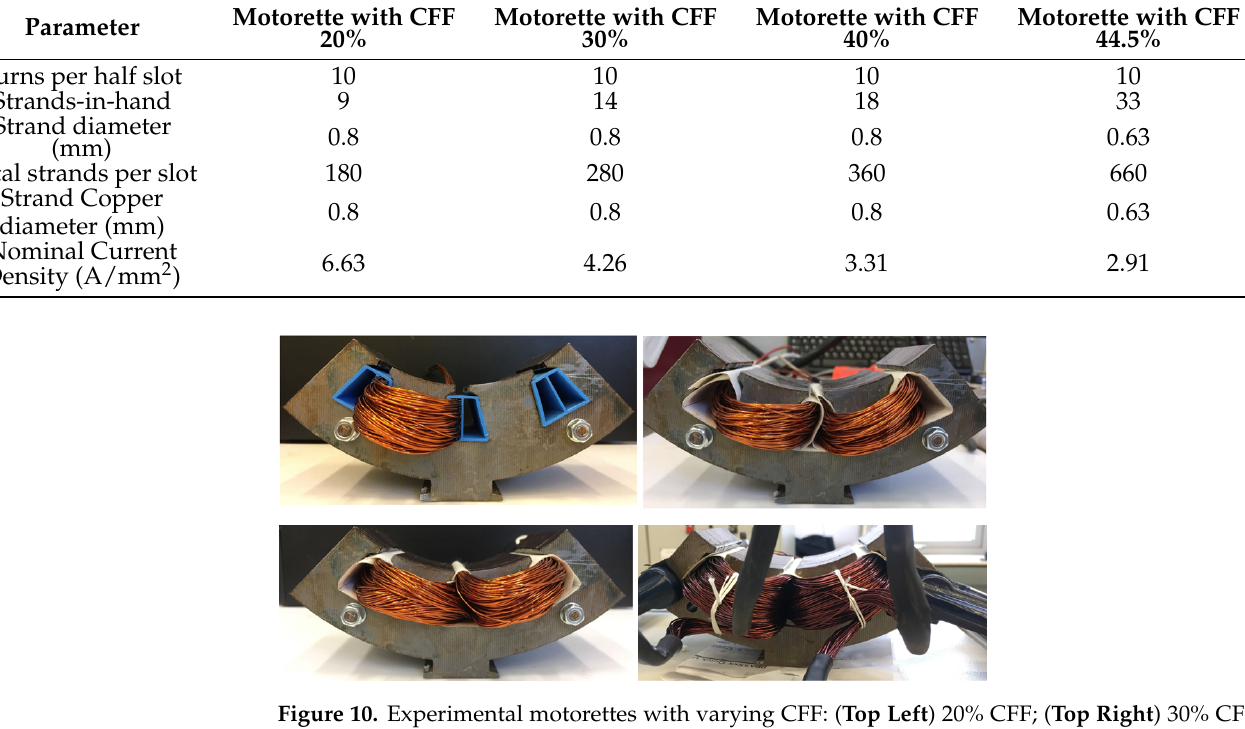
Table 5. Specifications in the slot for motorettes with varying copper filling factor (CFF).